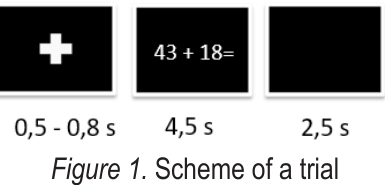
Figure 1. Scheme of a